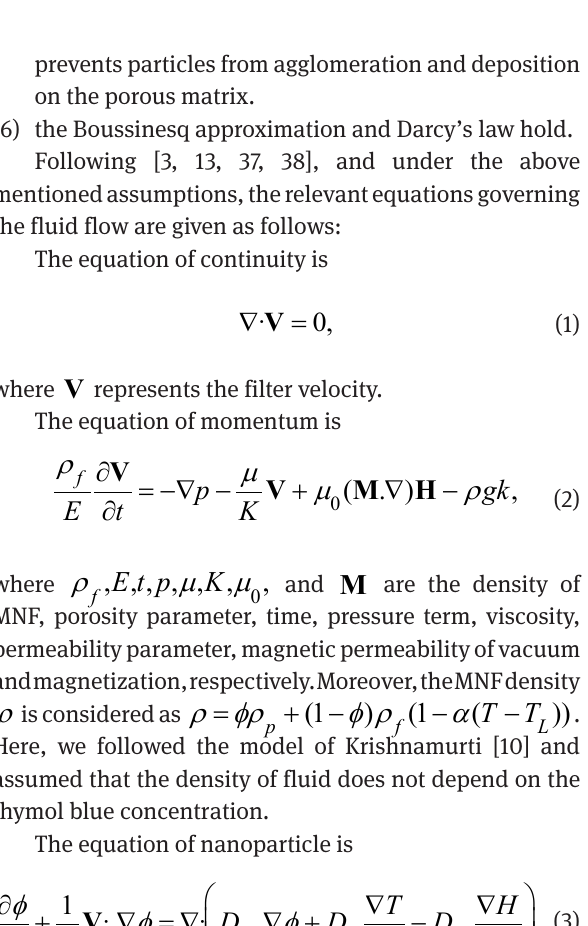
Figure 1: Physical